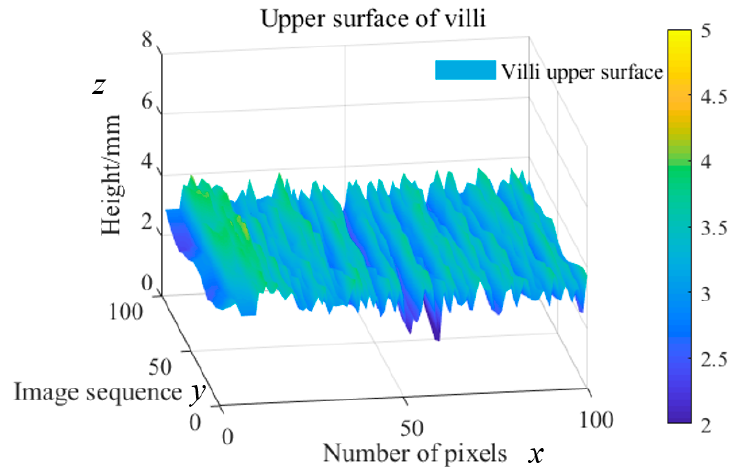
Figure 3. 3D reconstruction of fabric surface.